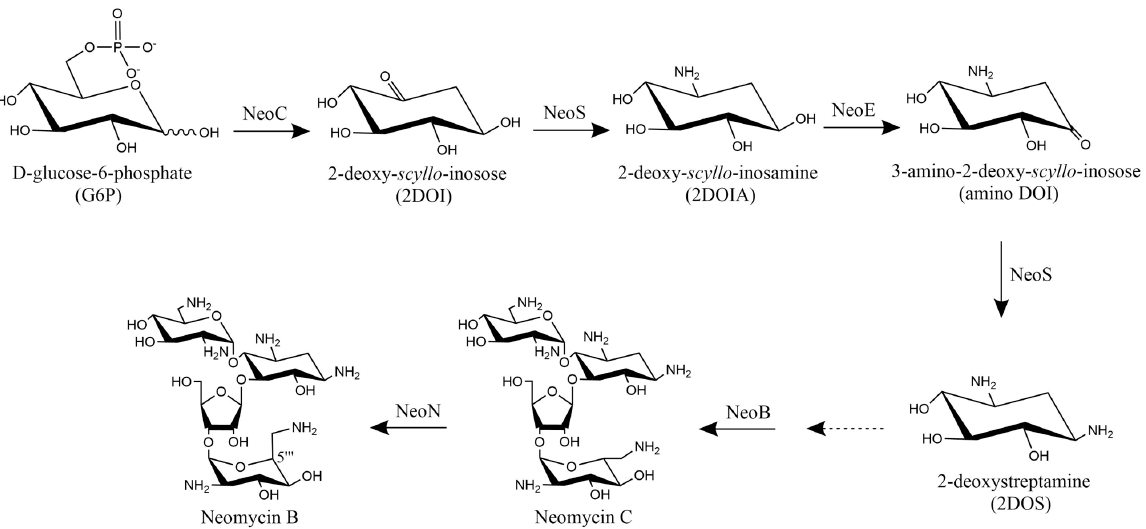
Figure 7. The biosynthetic pathway of neomycin B. NeoC: 2-deoxy- scyllo -inosose (2DOI) syn- thase; NeoS: 2DOI aminotransferase; NeoE: 2-deoxy- scyllo -inosamine dehydrogenase; NeoB: 6 (cid:48) - oxoparomamine aminotransferase; NeoN: neomycin C 5 (cid:48)(cid:48)(cid:48)